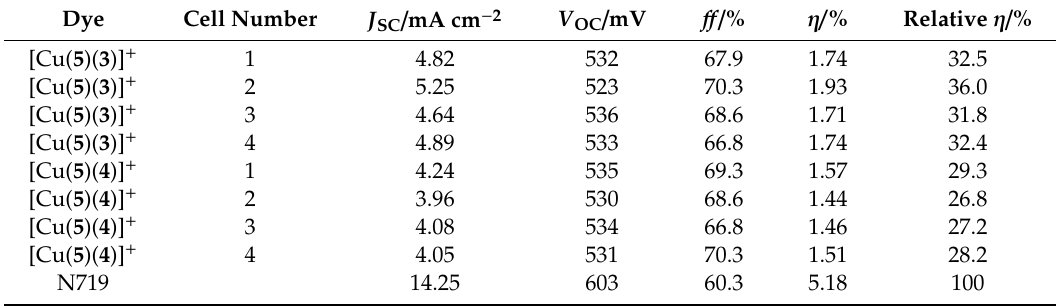
Figure 10. J–V curves for sets of four DSCs sensitized with [Cu( 5 )( 3 )] + (blue curves) and [Cu( 5 )( 4 )] + (red curves) measured on the day of sealing the cells. Table 2. Performance parameters (under 1 sun illumination) of duplicate, masked DSCs on the day of sealing the cells with the dyes [Cu( 5 )( 3 )] + and [Cu( 5 )( 4 )] + . The data are compared to a DSC containing N719 and relative η values are with respect to N719 set at